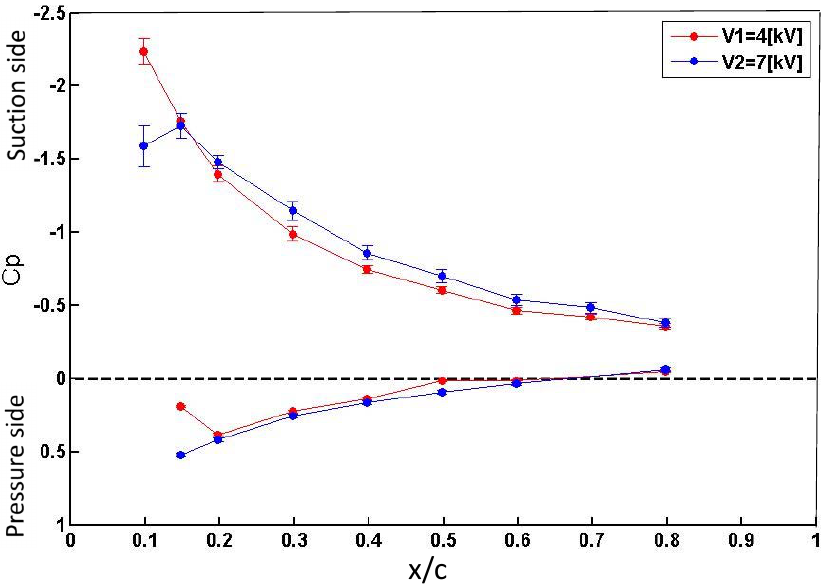
Figure 18. C p distribution comparing applied voltages at Re = 100,000 and α = 16 ◦ , and actuation frequency f = 66.6Hz.